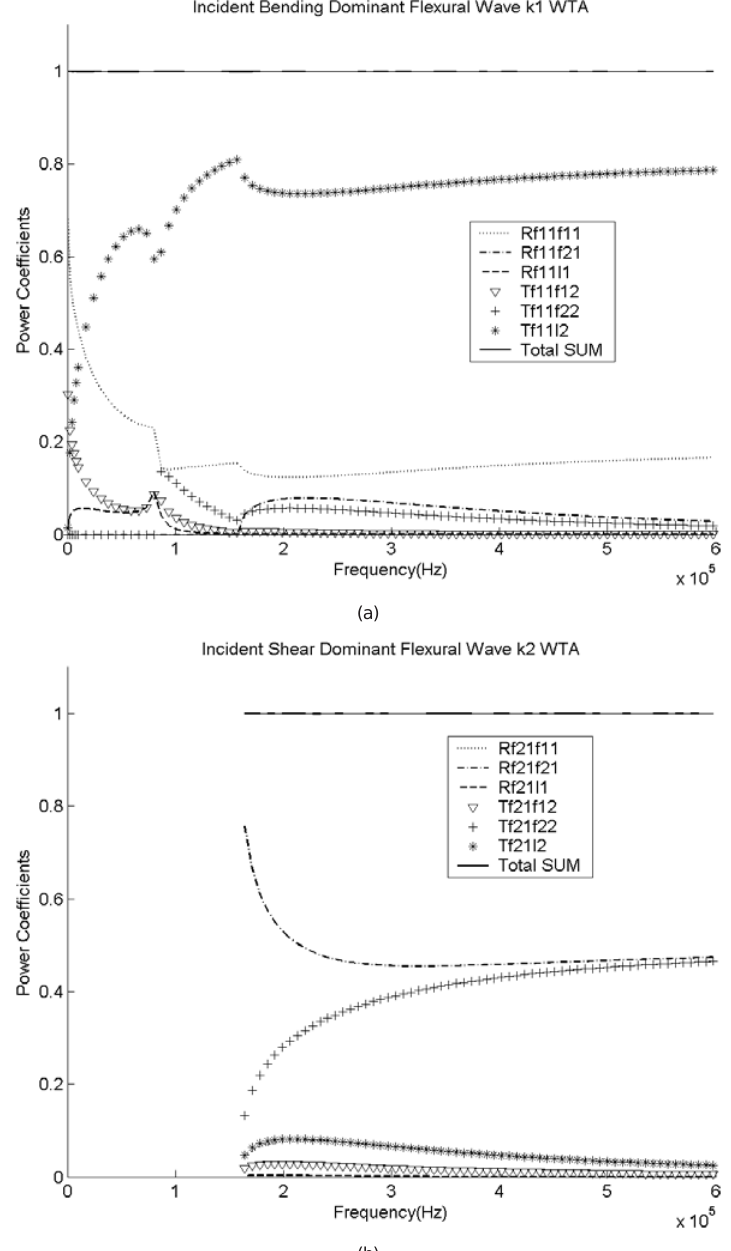
Fig. 7. The power transmission and reflection coefficients of two semi-infinite Timoshenko beams with different material and geometrical properties joined at 90 ◦ : (a) Case of the incident BDFW with wavenumber k 1 , (b) Case of the incident SDFW with wavenumber k 2 , (c) Case of the incident longitudinal